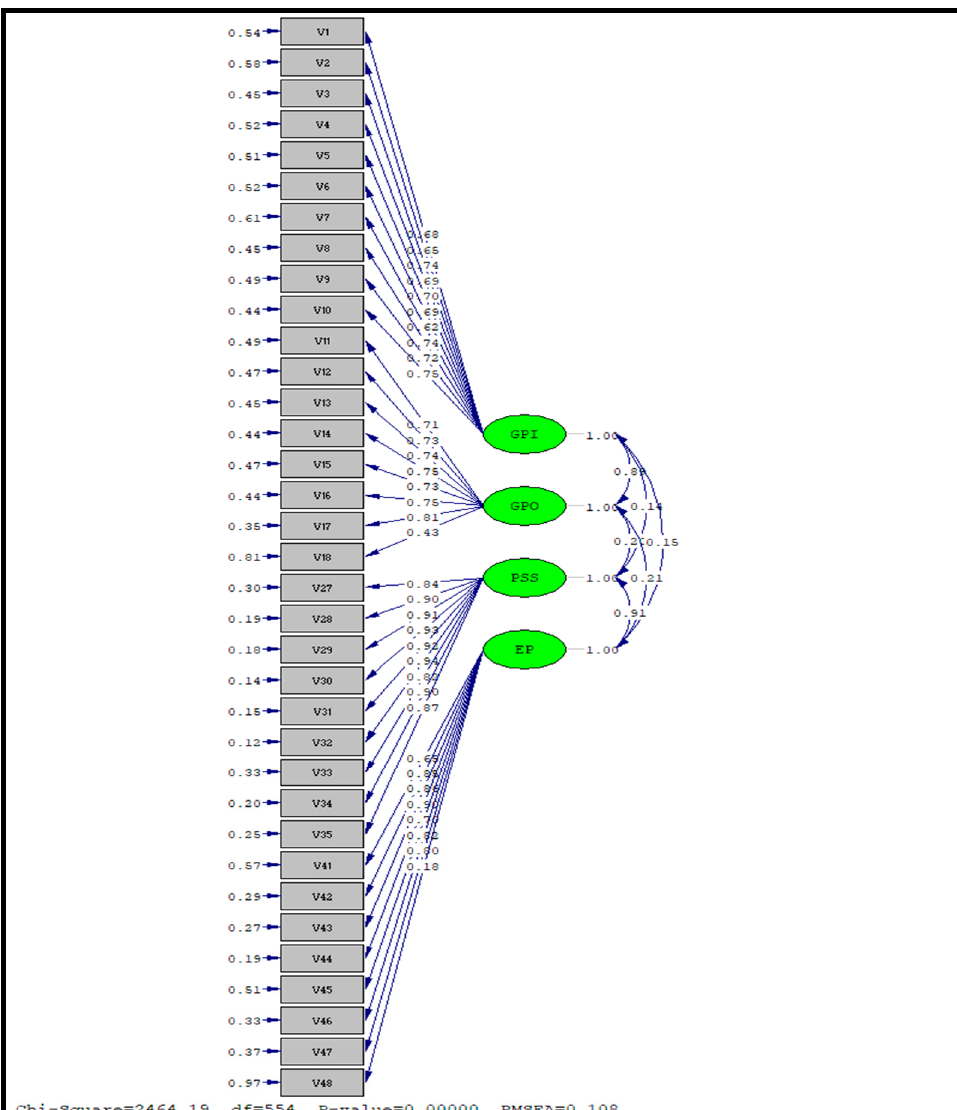
Figure 2. Confirmatory Factor Analysis. Table 4. Cronbach ‘s alpha, CR, and VE.